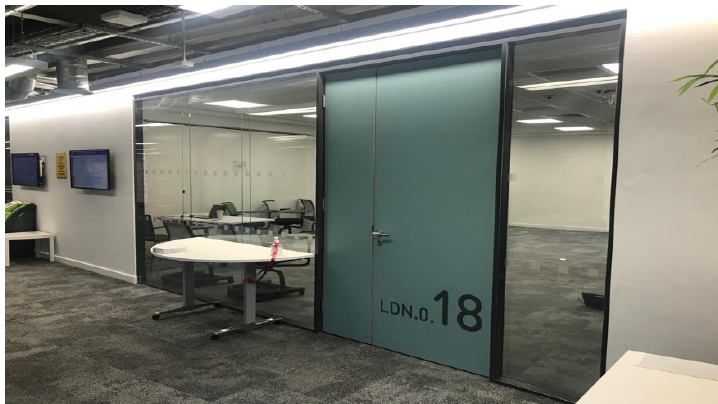
Figure 13. Experiment 2 room.